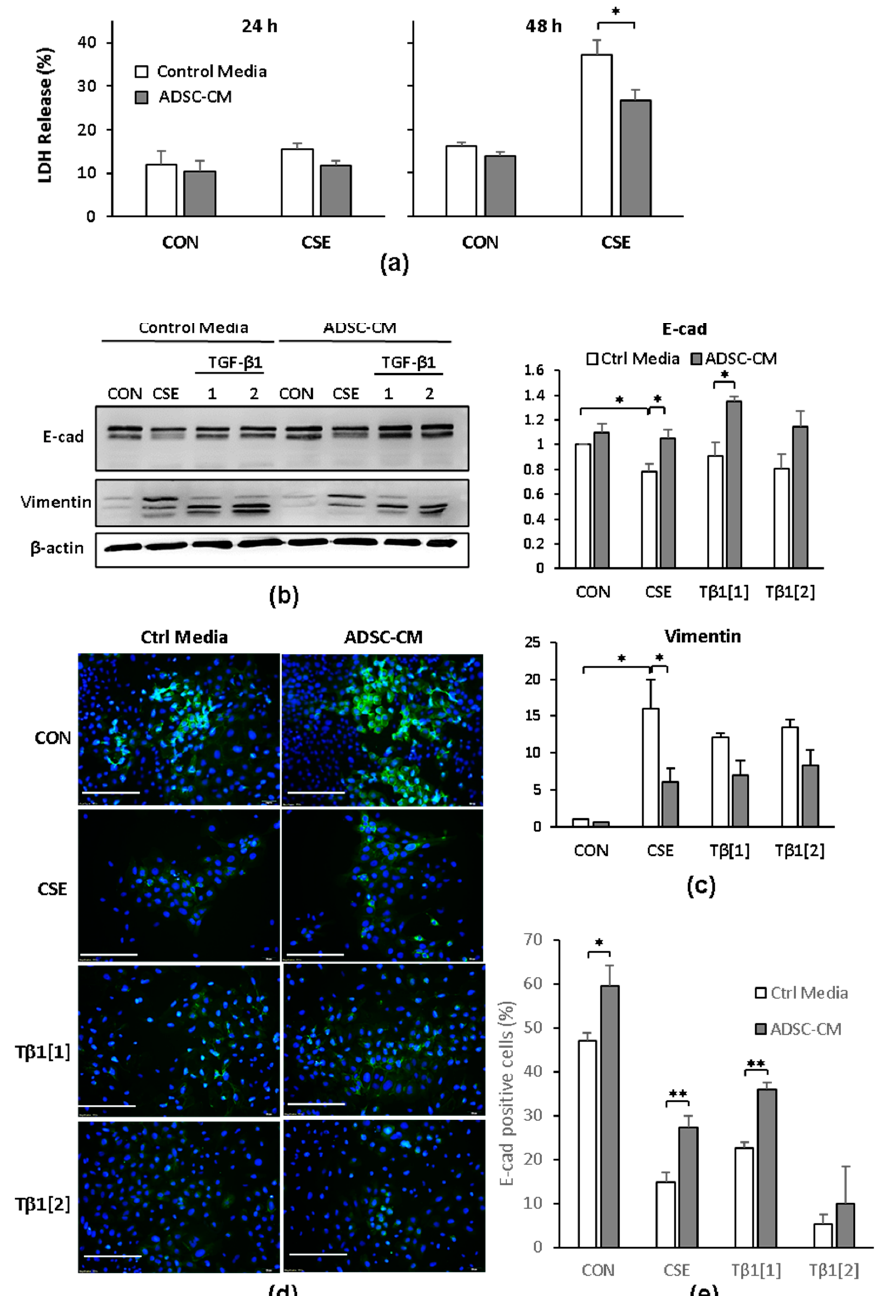
Figure 5. CSE- and TGF- β 1-induced cell death and EMT in Beas-2B (B2B) cells blocked by ADSC-CM. ( a ) LDH release by B2B cells in control medium or ADSC-CM kept as control or treated with 50 µ g/mL CSE. * p < 0.05. ( b ) E-cad, vimentin, and β -actin expression by immunoblotting in B2B cells treated with 0, 50 µ g/mL CSE and 1 or 2 ng/mL TGF- β 1 (T β 1[1], T β 1[2]) for 72 h. ( c ) Summary of densitometry analysis of E-cad and vimentin expression normalized to the level of β -actin. The results shown were summarized from five independent experiments showing values normalized to control medium groups. * p < 0.05. ( d ) Immunofluorescent staining of E-cadherin in B2B cells kept in control media or ADSC-CM and treated with CSE and 1 or 2 ng/mL TGF- β 1 for 72 h. Scale bar = 200 µ m. ( e ) Percentage of cells in ( d ) that showed positive staining for E-cadherin. Images from three independent experiments were analyzed. ** p < 0.01 compared to control media group. ADSC, adipose-derived stem cell; CM, conditioned medium; CON, control; CSE, cigarette smoke